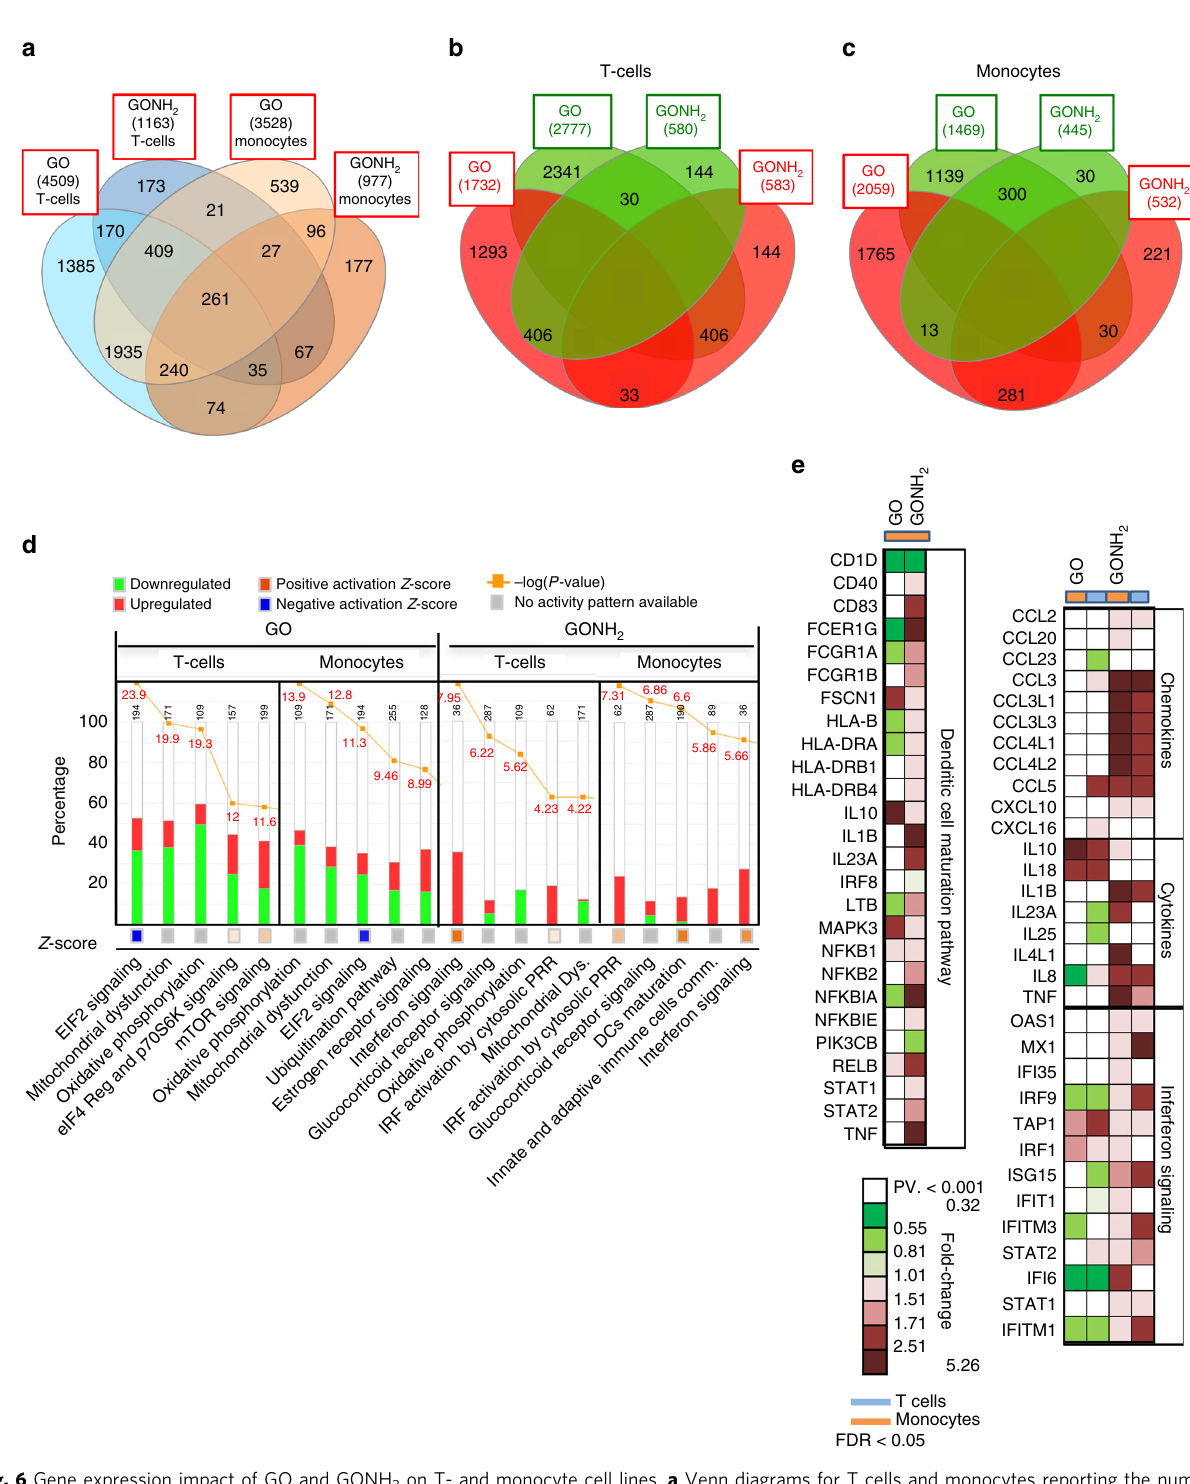
Fig. 6 Gene expression impact of GO and GONH 2 on T- and monocyte cell lines. a Venn diagrams for T cells and monocytes reporting the number of transcripts modulated in response to graphene administration. Each Venn diagram is divided into four areas, one for each type of GO and GONH 2 in T cells and monocytes. The total number of modulated genes in each area is reported between the parentheses. b Venn diagrams of differently expressed transcripts in T cells and c in monocytes. Overlapping areas indicate the number of transcripts commonly changed in their expression level between GO and GONH 2 . Colored circles indicate the number of upregulated (red) and downregulated (green) transcripts with an absolute fold change > 1. d Top fi ve fi rst canonical pathways ranking according to signi fi cance level (Fisher exact test log ( P -value) reported in red) modulated by the GO and GONH and monocytes identi fi ed using gene enrichment analysis. The Z -score of each pathway is expressed under each column; the – log( P -value) is reported in red on top of each histogram. e Expression heat map of chemokines, cytokines, dendritic cell maturation, and interferon signaling pathway genes (as listed in IPA software) in GONH 2 - and GO-treated cells vs. Controls; P -value < 0.001 and FDR <